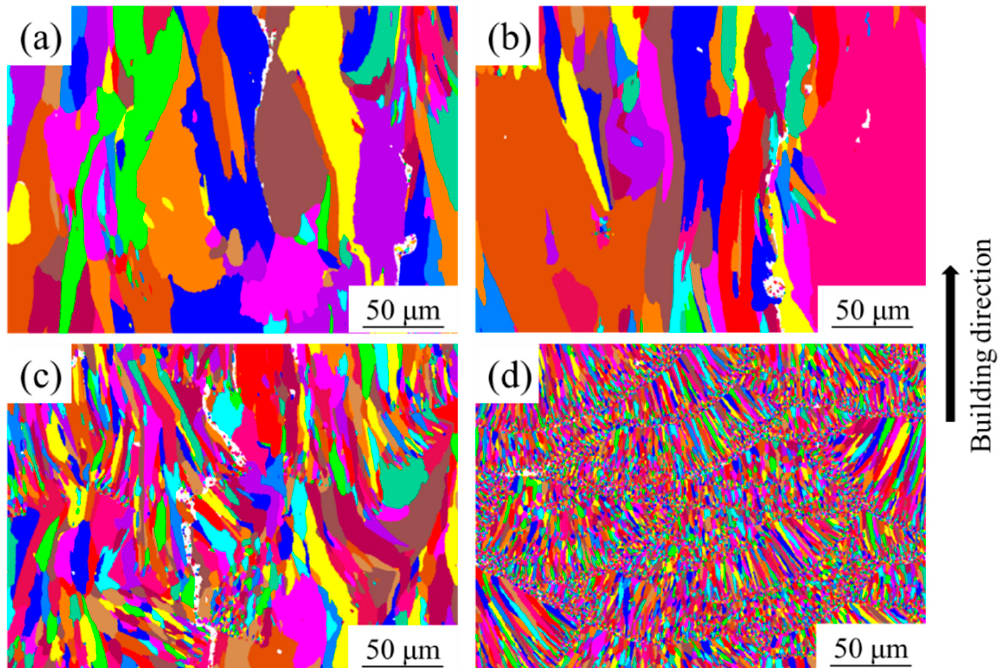
Figure 11. EBSD analysis of Al-6.2Zn-2Mg-xSc-xZr alloy samples, ( a ) sample 1, ( b ) sample 2, ( c ) sample 3, ( d ) sample 4.